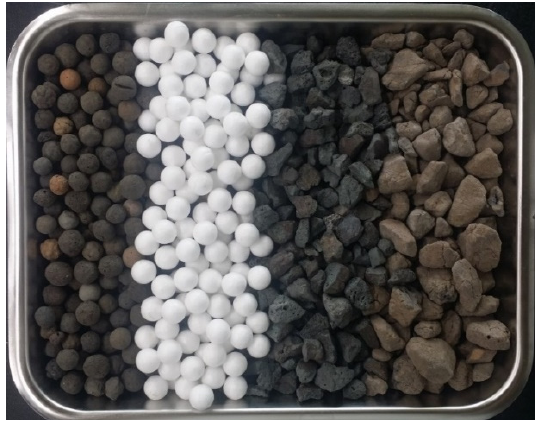
Figure 2. Shape of lightweight aggregates (B700, EPS, ST700, and AS700 from left to right).